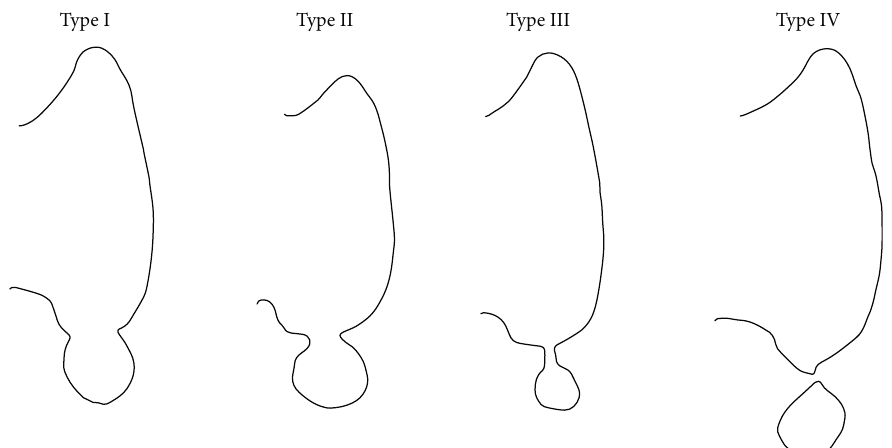
Figure 5: Thyroid rests types I-IV. Type I: a protrusion of thyroid tissue from the inferior of the thyroid gland and distinct from the lower border of the thyroid lobe. Type II: thyroid tissue within the thyrothymic tract and attached to the thyroid by a narrow pedicle of thyroid tissue. Type III: thyroid tissue similar to type II but attached to the thyroid gland by a fi brovascular core. Type IV: has no thyroid gland connection